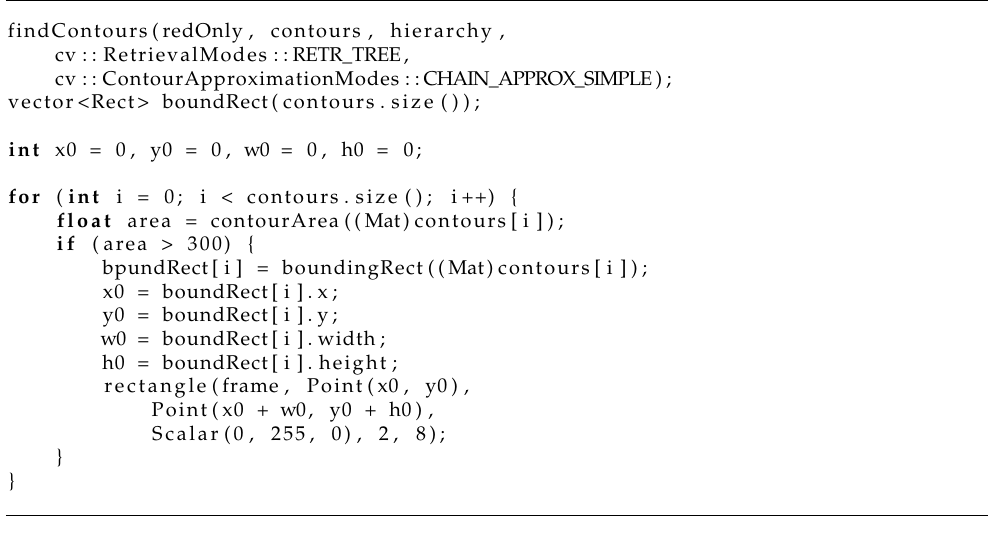
Algorithm 2 Colour detection algorithm in C++.